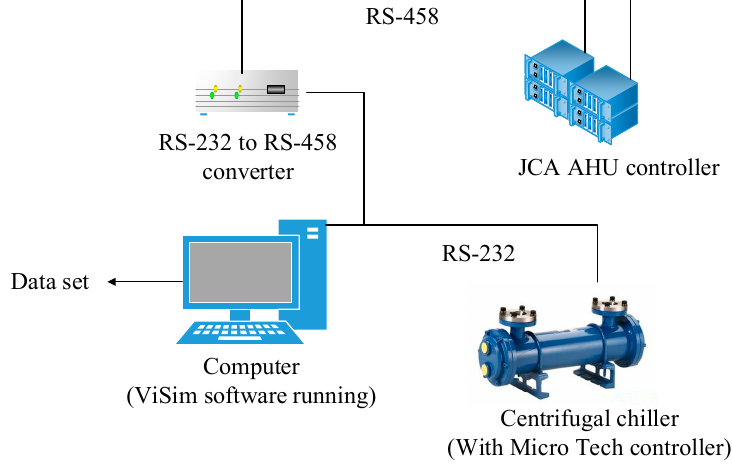
Figure 4. The data acquisition system.